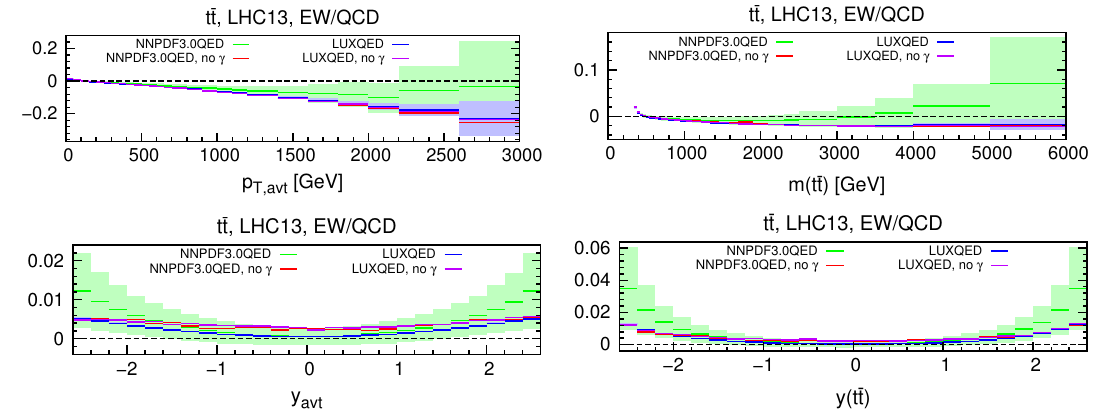
Figure 6 . Impact of the photon PDF on the p T; avt , m ( t (cid:22) t ), y avt and y ( t (cid:22) t ) di(cid:11)erential distributions at 13 TeV. The format of the plots is described in the